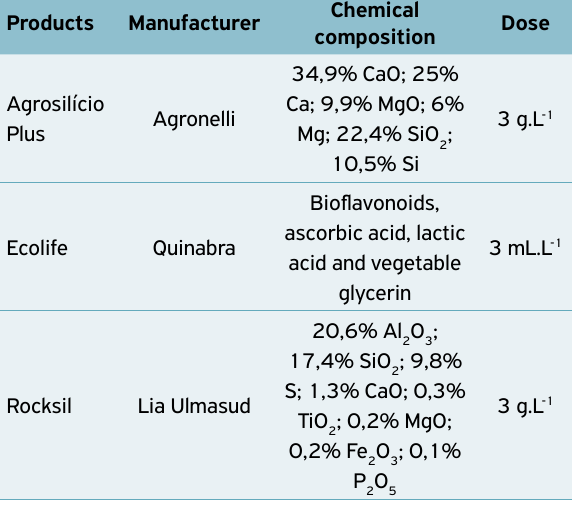
Table 1. Description of treatments based on resistance inducers used in the